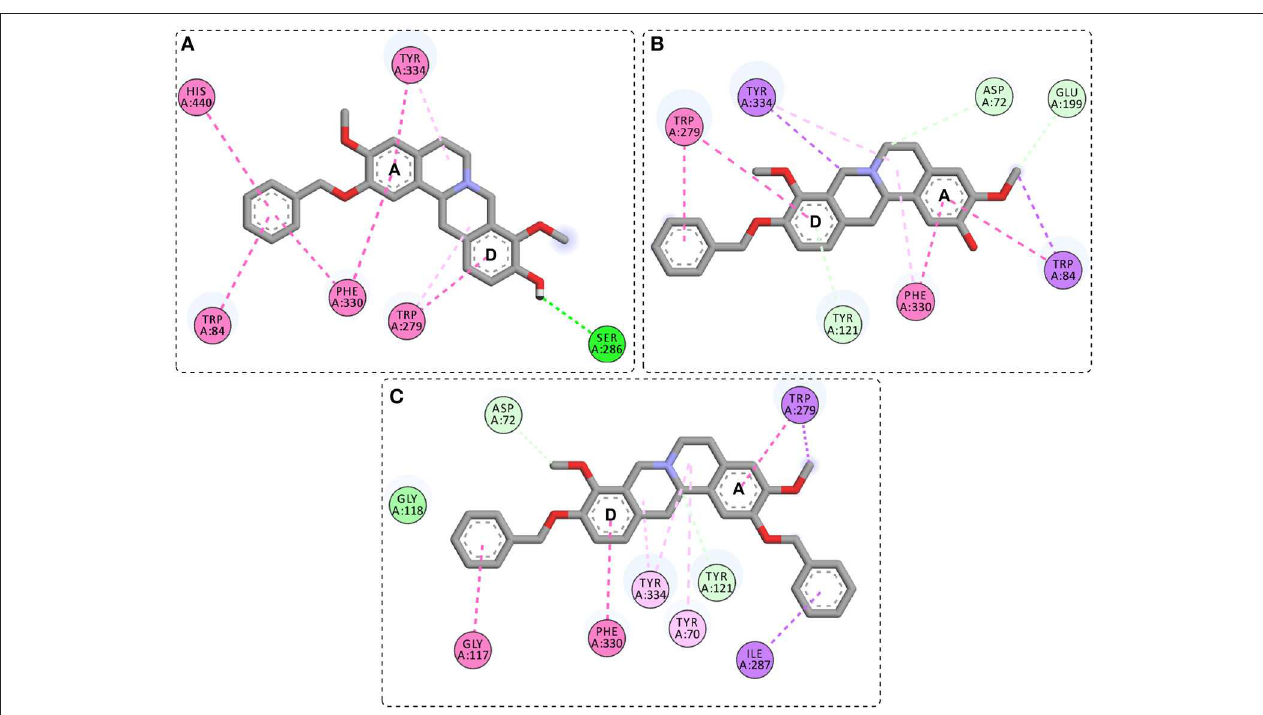
FIGURE 4 | General interactions between compound 1c (A) , 1d (B) , and 1e (C) , and the Tc AChE enzyme by 2D